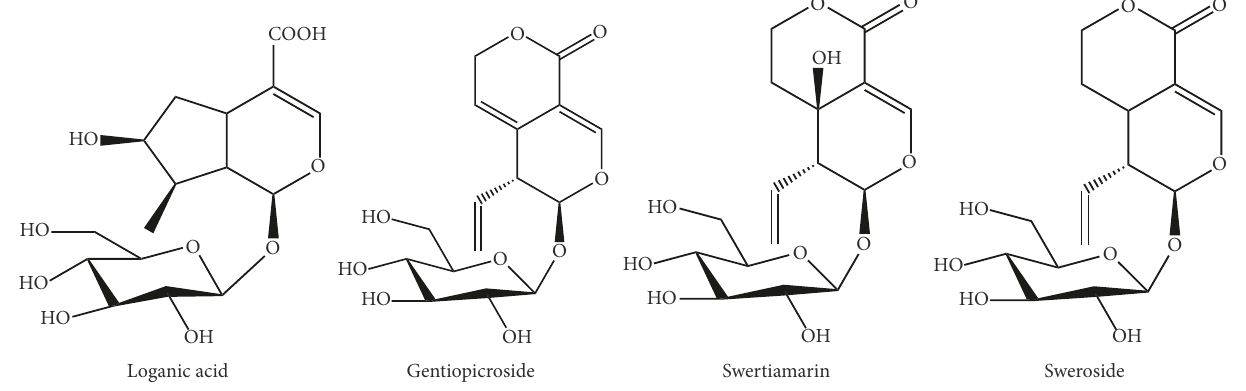
Figure 1: The chemical structures of biomarkers of G. rigescens